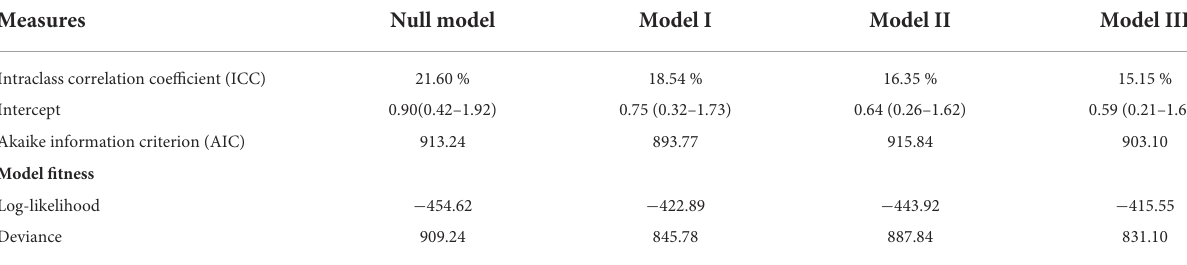
TABLE 1 Random effect and model comparison for factors associated with childhood overweight/obesity.